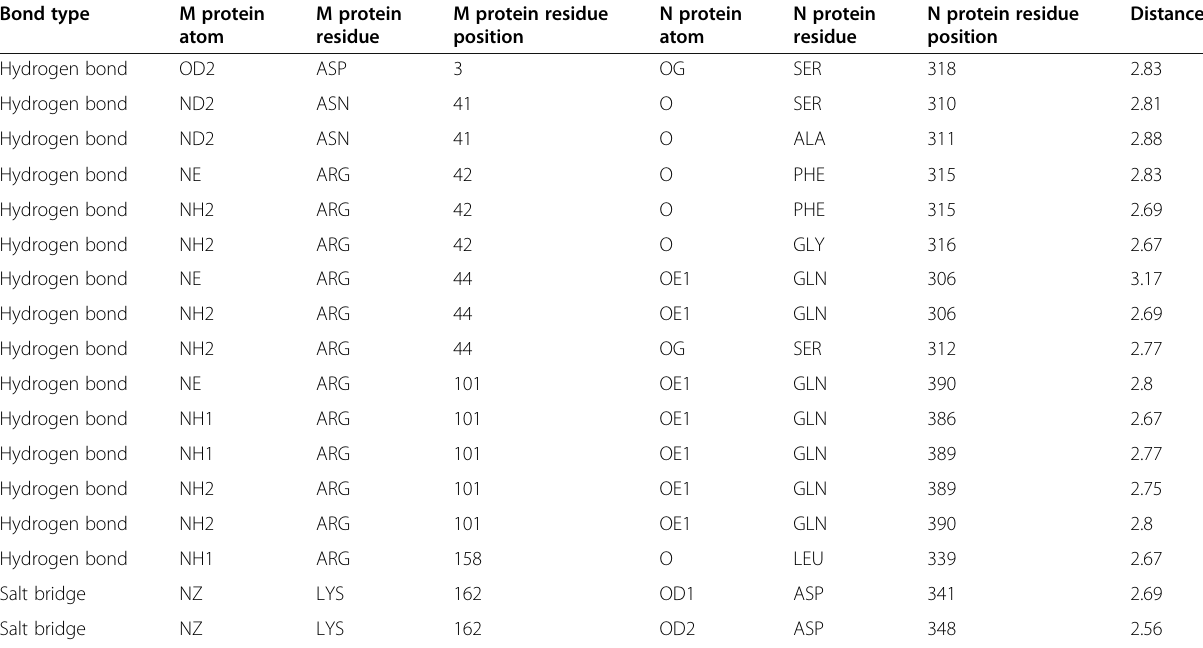
Table 2 Residues involved in hydrogen bonds and salt bridges between the wild type N protein and the M protein Bond type